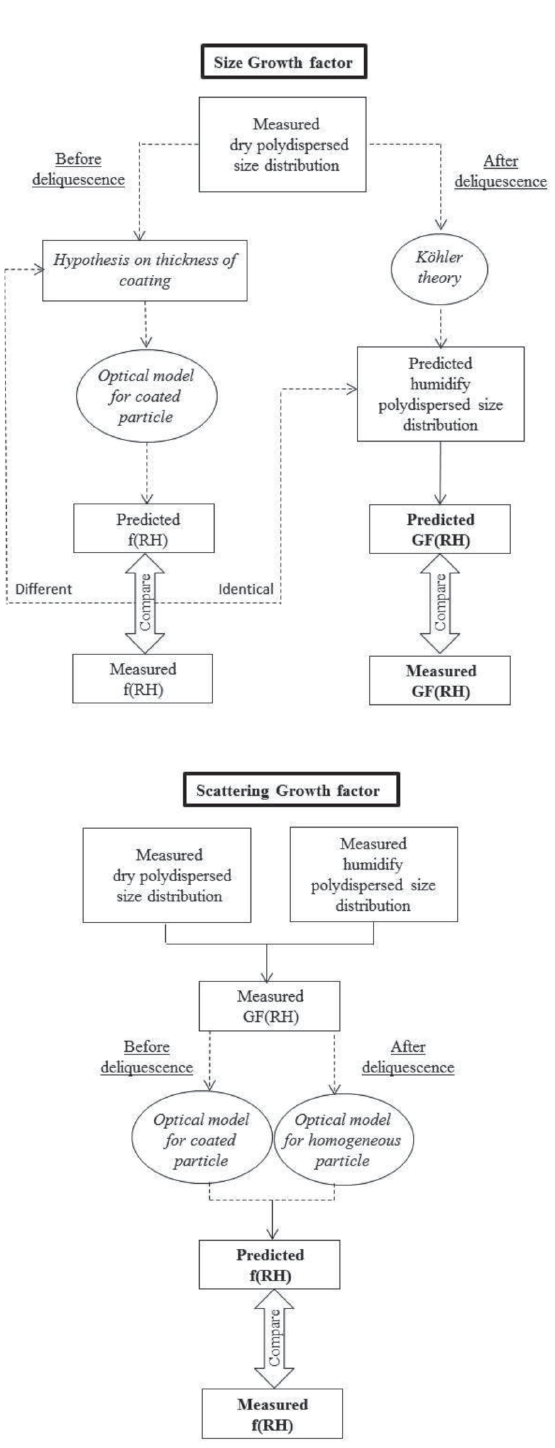
Fig. 10. Method used to compare measured and predicted size and scattering growth factor.